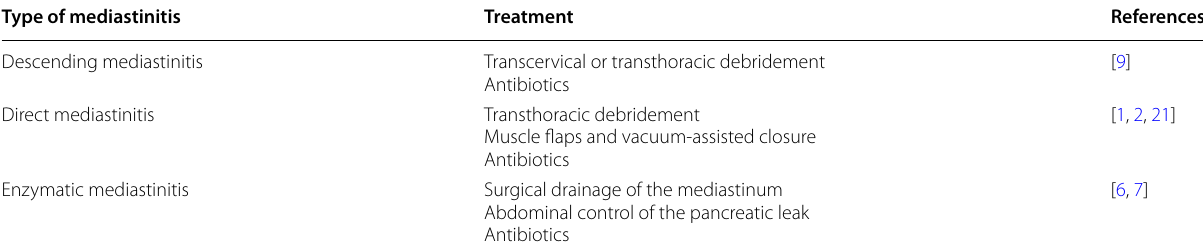
Early debridement and reconstructive procedures are recommended in treating mediastinitis, though the approach is controversial due to the different etiology